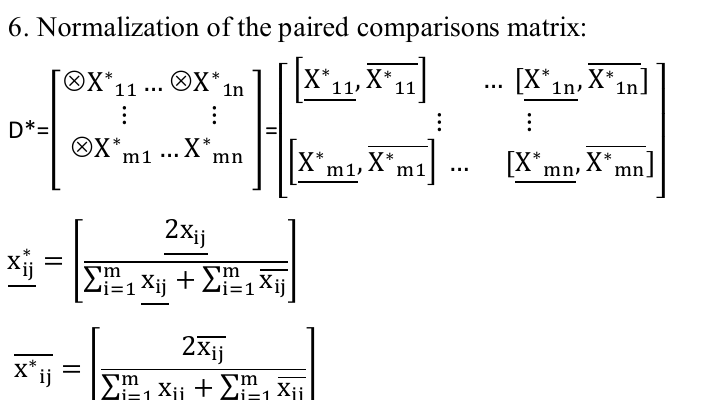
Fig. 1. Hierarchy